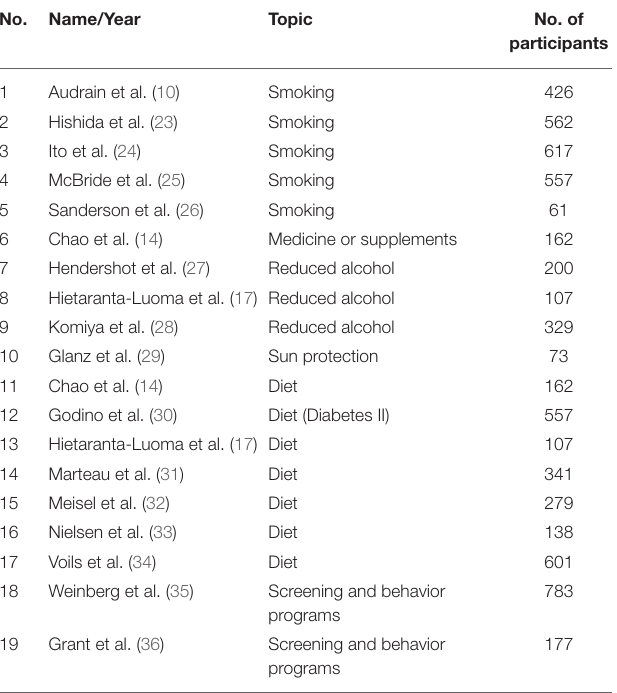
TABLE 1 | BMJ 2016;352:i1102 included clinical trials, their number, topic, and number of participants.